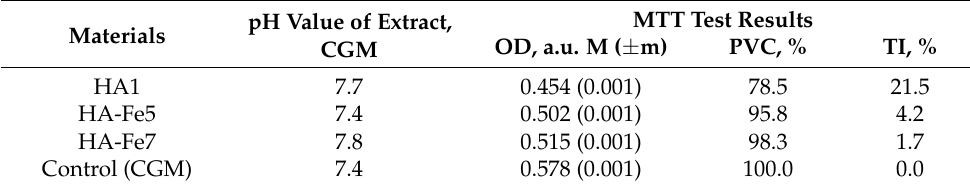
Figure 12. Table 5. The results of in vitro investigations: the pH of the extracts, the values of the optical density (OD) of the formazan solution (MTT test), the pool of viable cells (PVC), and the toxicity index (TI) during the cultivation of the MG-63